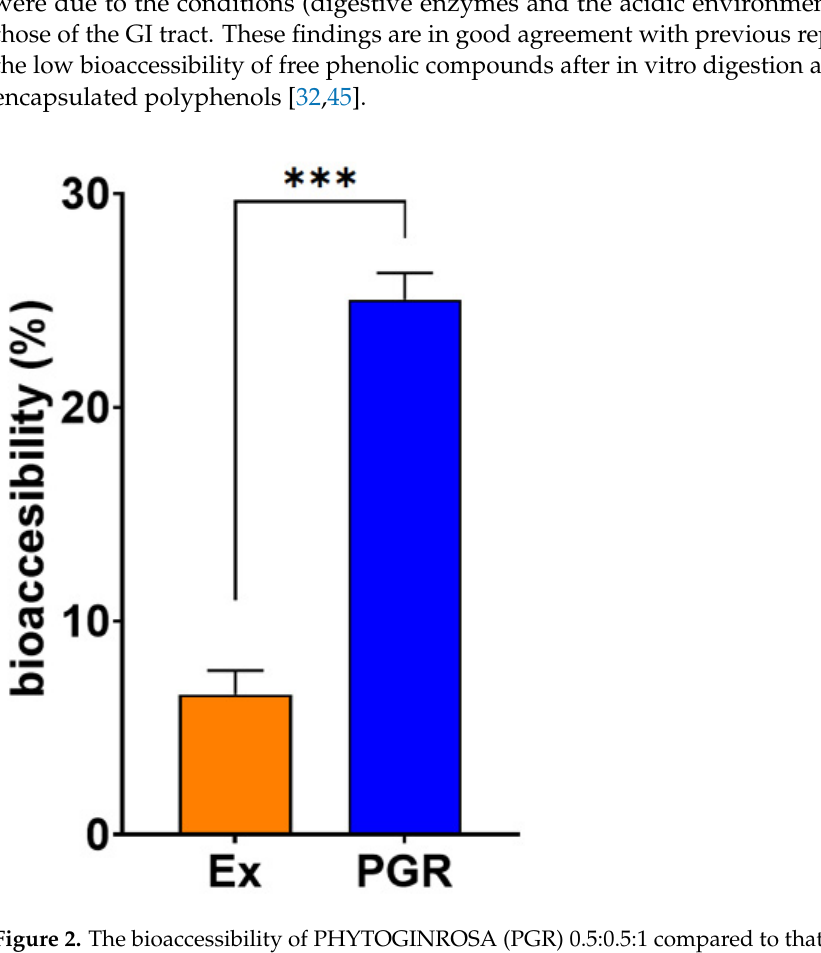
Figure 2. The bioaccessibility of PHYTOGINROSA (PGR) 0.5:0.5:1 compared to that of extracts (Ex) after exposure to simulated gastrointestinal conditions. The results are presented as means ± SD. *** p < 0.001 for PGR vs. Ex.